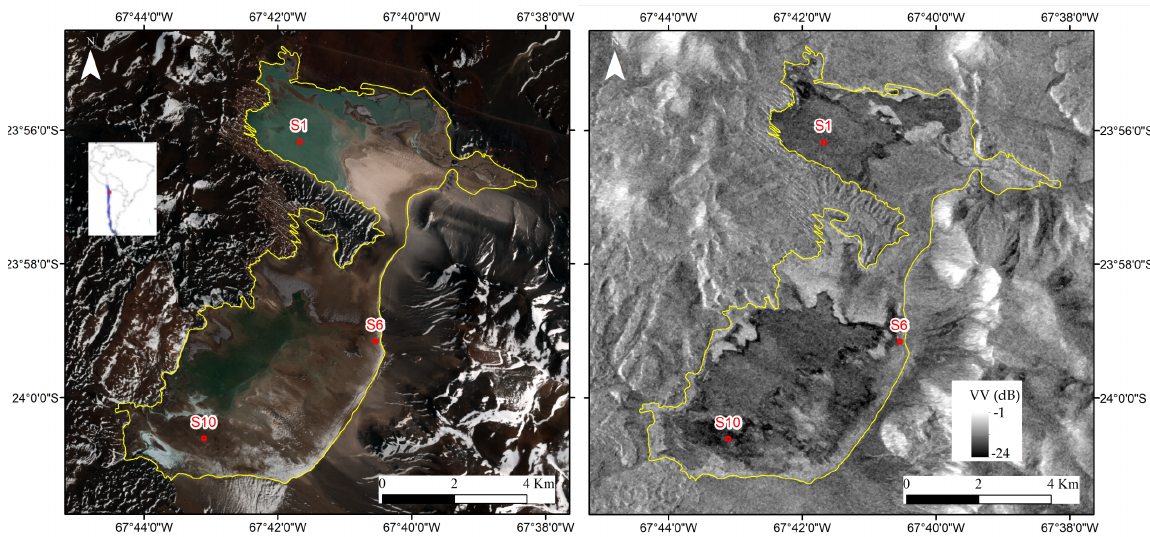
Figure 1. Study area on September 11, 2017. Left: True color (Sentinel 2). Right: C-band SAR (Sentinel 1). Center coordinates are 67°41’16”W and